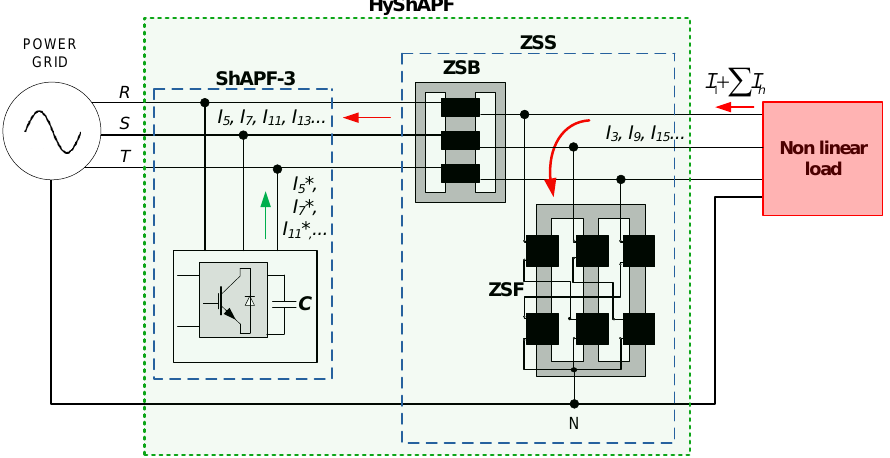
Figure 8. Proposed hybrid filtering arrangement (HyShAPF).